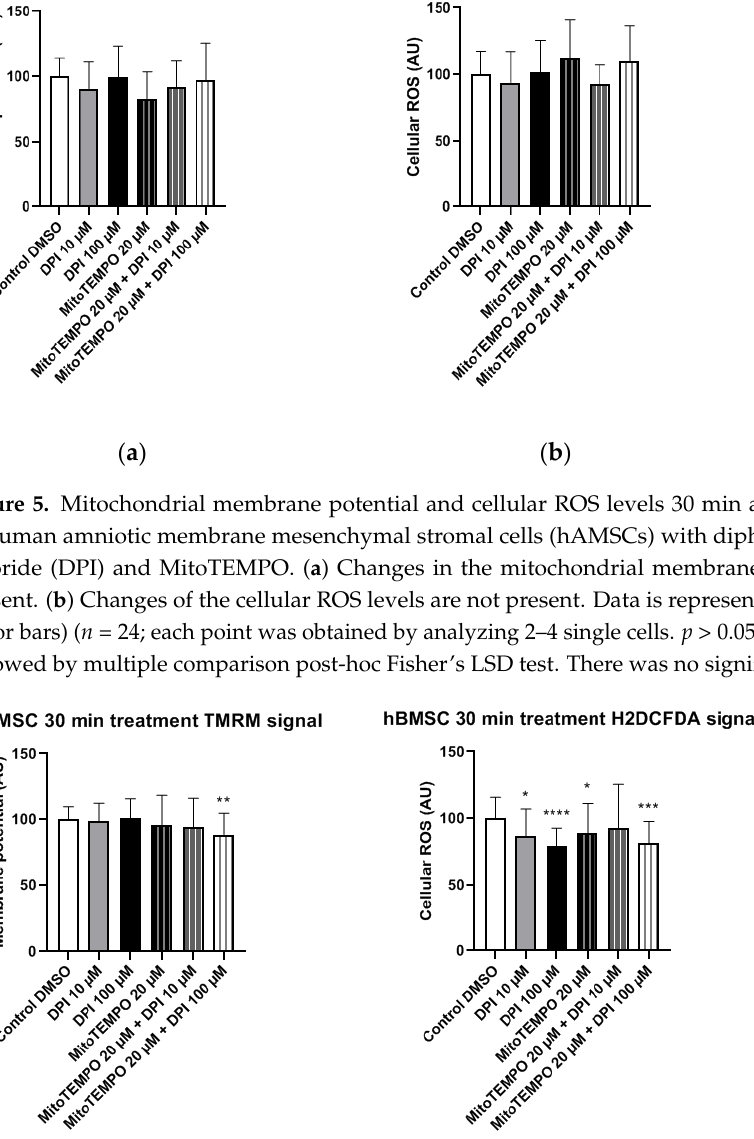
Figure 6. Mitochondrial membrane potential and cellular ROS levels 30 min after the treatment of hBMSCs with diphenyleneiodonium chloride (DPI) and MitoTEMPO. ( a ) Changes in the mitochondrial membrane potential. ( b ) Changes of the cellular ROS levels. Data is represented as means + SD (error bars) ( n = 36; each point was obtained by analyzing 2–4 single cells. * p < 0.05, ** p < 0.01, *** p < 0.001, and **** p < 0.0001; one-way ANOVA followed by multiple comparison post-hoc Fisher’s LSD test.